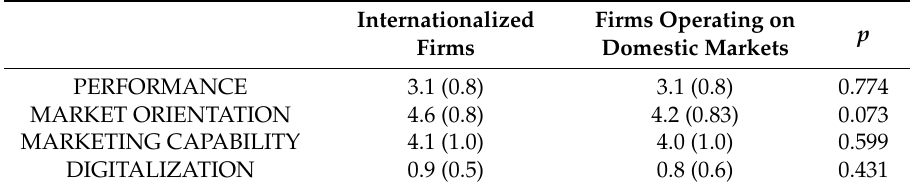
Table 2. Mean values, (standard deviations) and probability values ( t -test) of variables.